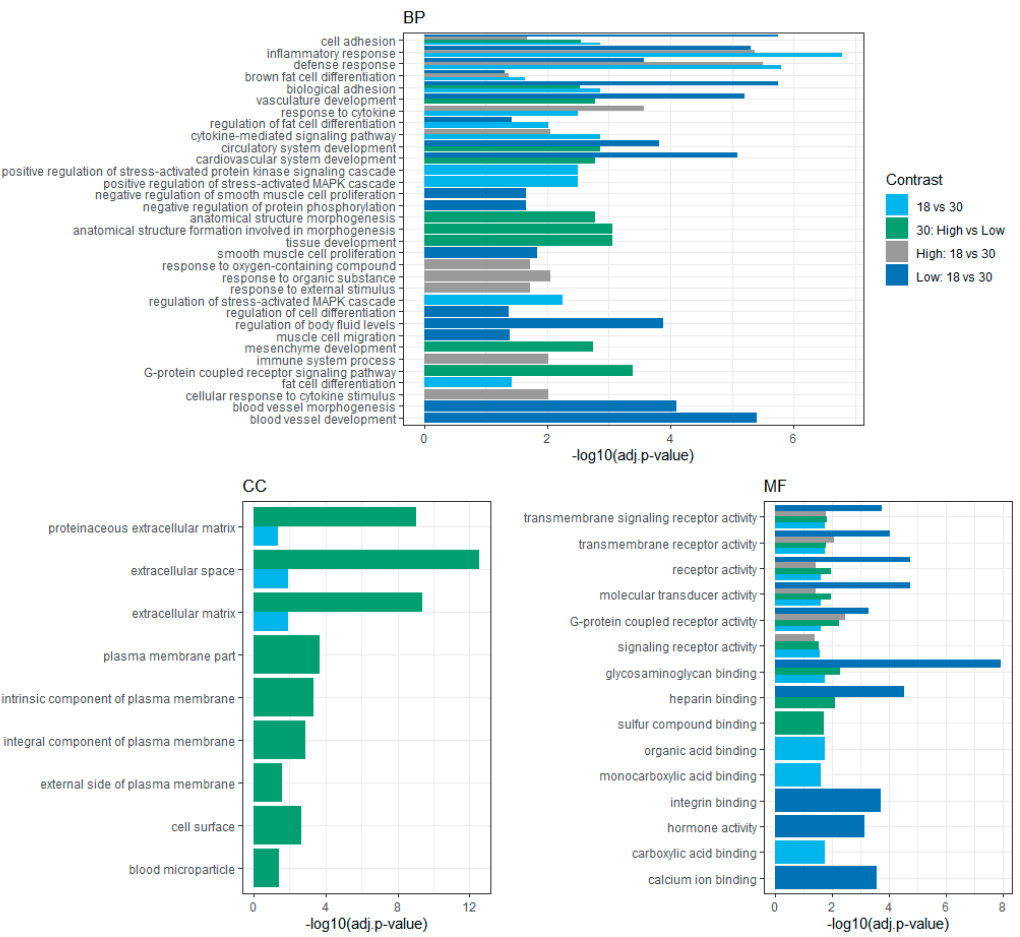
Figure 4. Top 10 significant GO terms and terms related to fat deposition and growth in Hanwoo. BP: biological process; CC: cellular components; MF: molecular function.